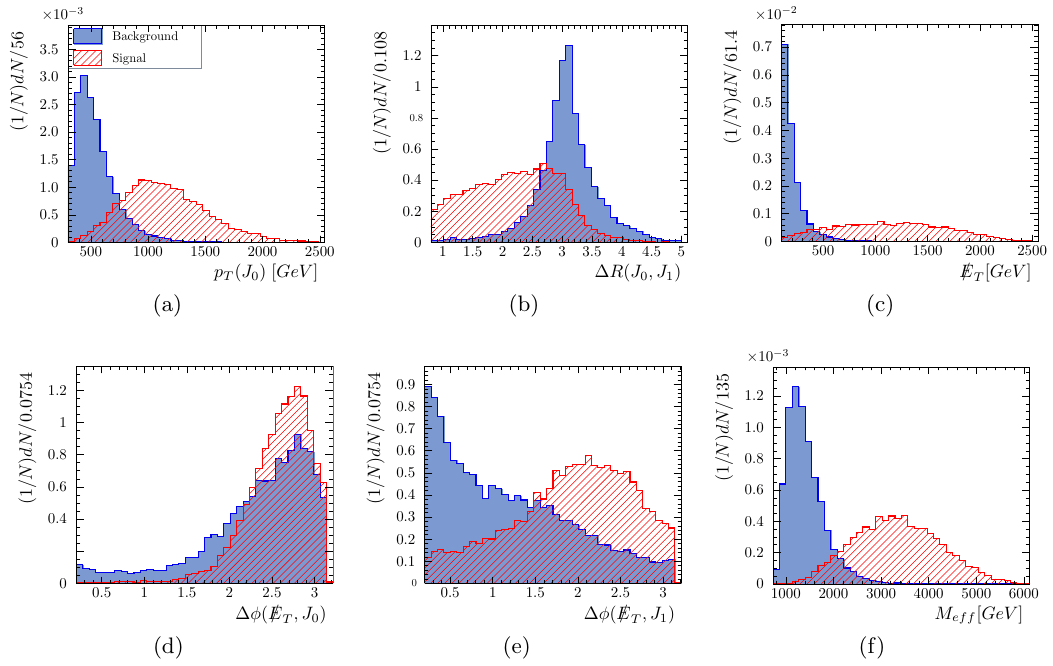
Figure 2 . Normalized distributions of the basic input variables related to two reconstructed fat-jets J i and missing transverse energy =E T at the LHC ( p s = 14 TeV) used in the MVA for the signal (red) and the background (blue). Signal distributions are obtained for benchmark point BP1 and the background includes all the dominant